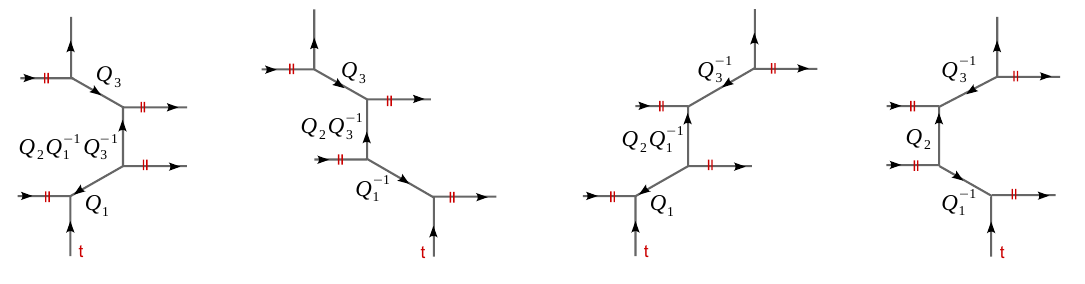
Figure 10 . Di(cid:11)erent strip diagrams related by